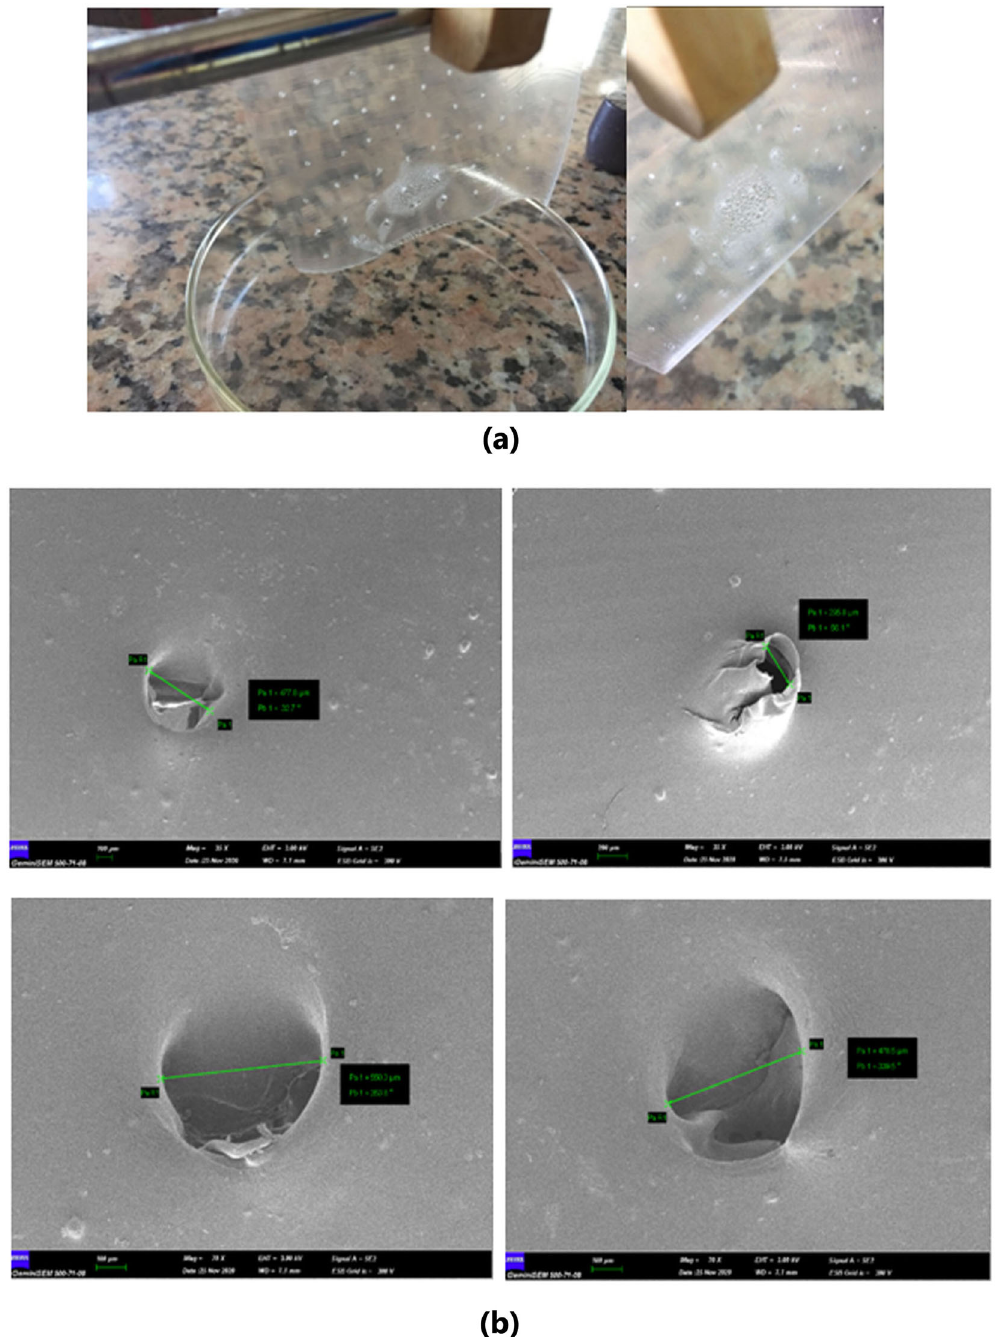
Fig. 10 Water collected in 1 min, and the diameter of the holes on the sample surfaces, scanning electron microscope images. a The water droplets collected on the sample in 1 min. b The diameter of the holes drilled on the materials was taken through different measurements. The experiment was carried out under normal room conditions, at 20% humidity, and in an open room closed to the air fl